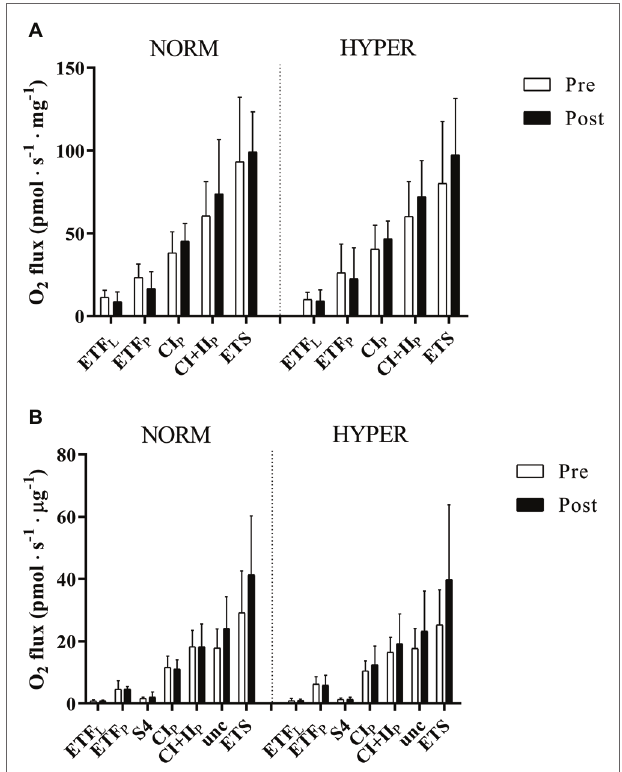
FIGURE 2 | Mitochondrial respiration pre and post 6 weeks polarized and periodized high-intensity interval training either in normoxia (NORM) or hyperoxic-supplemented (HYPER). All values are expressed as means ± SD. In panel (A) , O 2 flux rates obtained from measurement of mitochondrial respiration using permeabilized fibers technique are expressed in pmol s −1 mg −1 fibers initial wet weight, whereas in panel (B) , O 2 flux obtained from measurement of isolated mitochondria the O 2 flux rates are presented in pmol s −1 μg −1 protein. Electron-transferring flavoprotein complex (ETF), state 4 (S4), complex I (CI), complex I + II-linked substrate state (CI + II), and uncoupling state (Unc) electron transport system capacity (ETS). Leak respiration and oxidative phosphorylation are indicated by subscripts L and P,